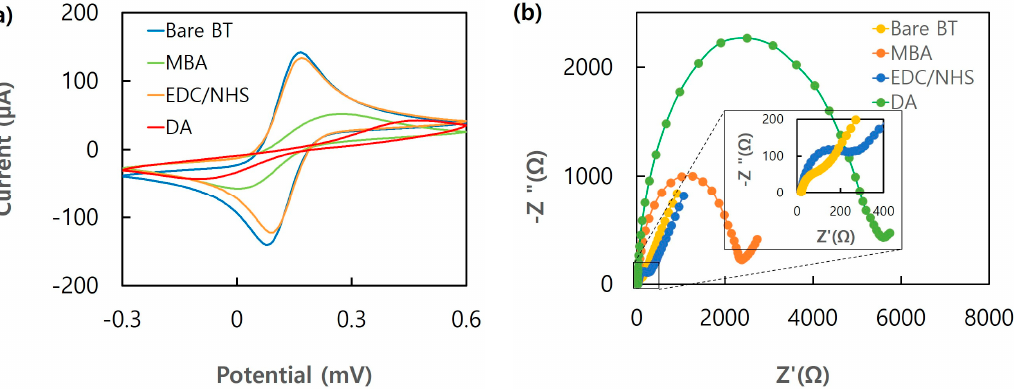
Figure 2. Electrochemical analysis for MBA- and DA-immobilized electrodes. ( a ) Cyclic voltammo- grams and ( b ) Nyquist plots obtained for surface-modified electrodes by applying 50 µL of 0.1 × PBS (pH 7.4) containing 10 mM Fe(CN) 63 − /4 − and 0.1 M KCl to the electrodes. Inset shows the enlarged image of the Nyquist plots of the bare electrode and EDC/NHS treated electrode.